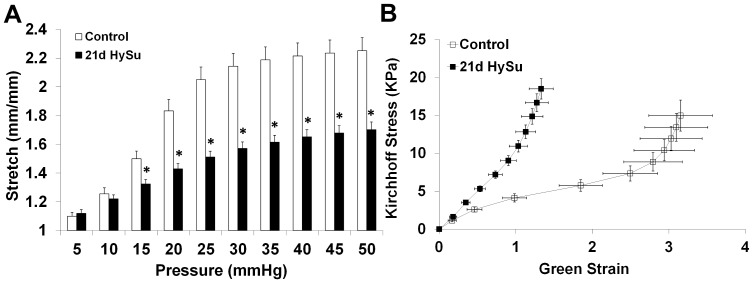
Pressure-stretch (A) and Kirchhoff stress- Green strain (B) relationships of large PAs obtained from static mechanical tests.N  =  5 per group. Means ± Standard Errors. * p<0.05 vs. control.